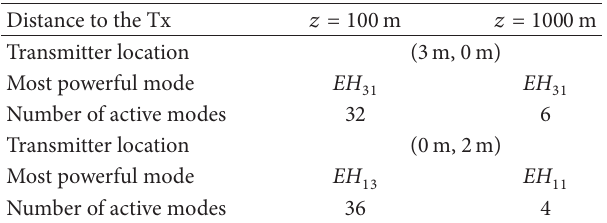
Table 2: Active modes related to the transmitter location in the tunnel.